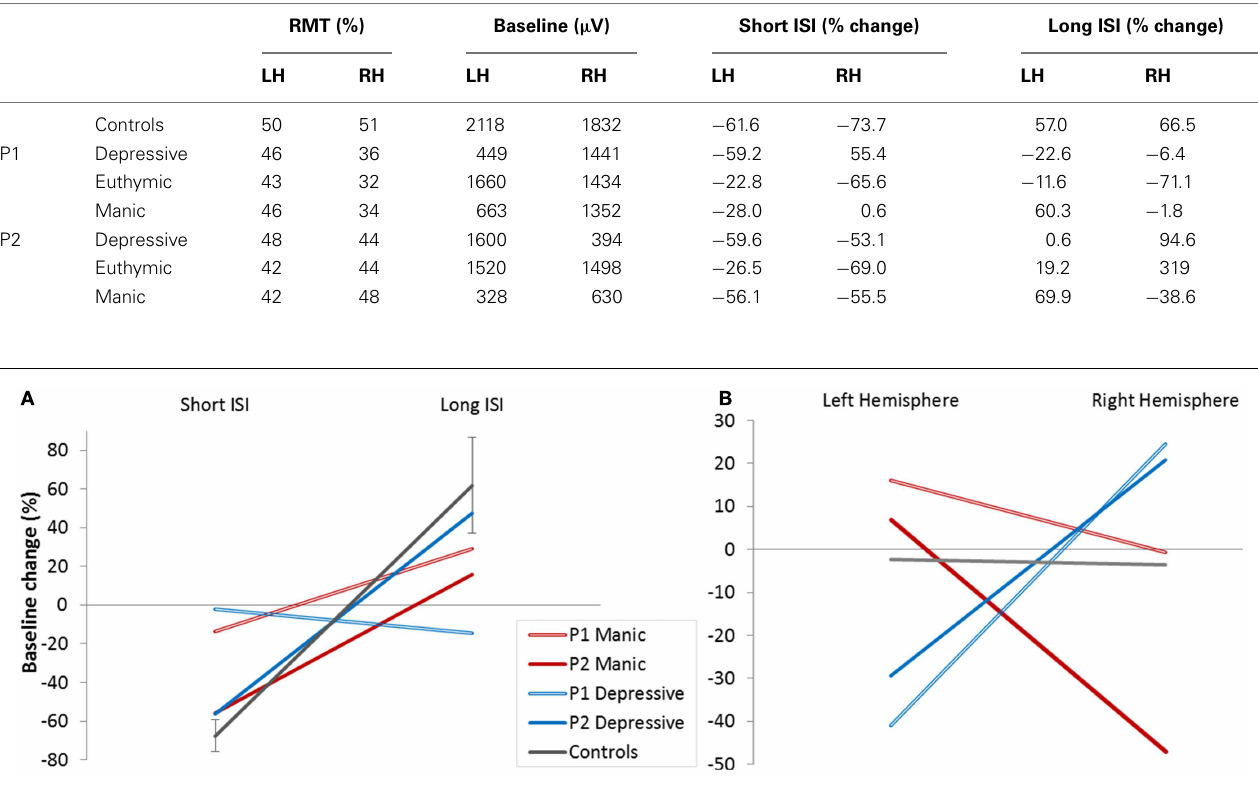
Table 3 | Resting motor threshold (RMT), baseline MEP amplitude, and intracortical effects for short and long ISI for each hemisphere (LH/RH) in controls and patients.